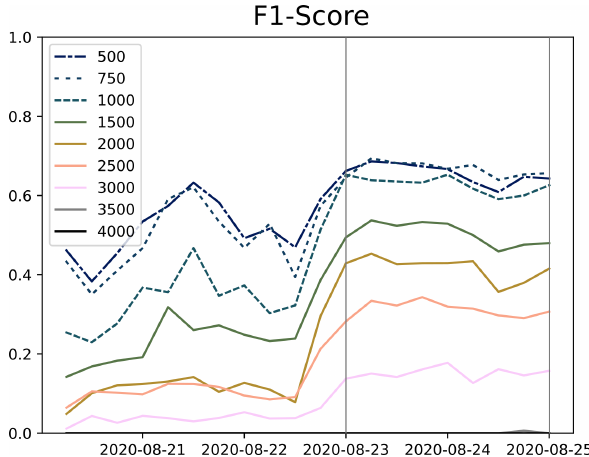
Figure 9. F1-score over time for each flight altitude. Altitudes of 500 m, 750 m and 1000 m are presented as dash-dotted, dotted, and dashed, respectively, to aid visual separation. The F1-score for 4000 m is zero throughout the time series. The colours correspond to the colour bar and the two grey lines correspond to the two epochs shown in Figure 10.